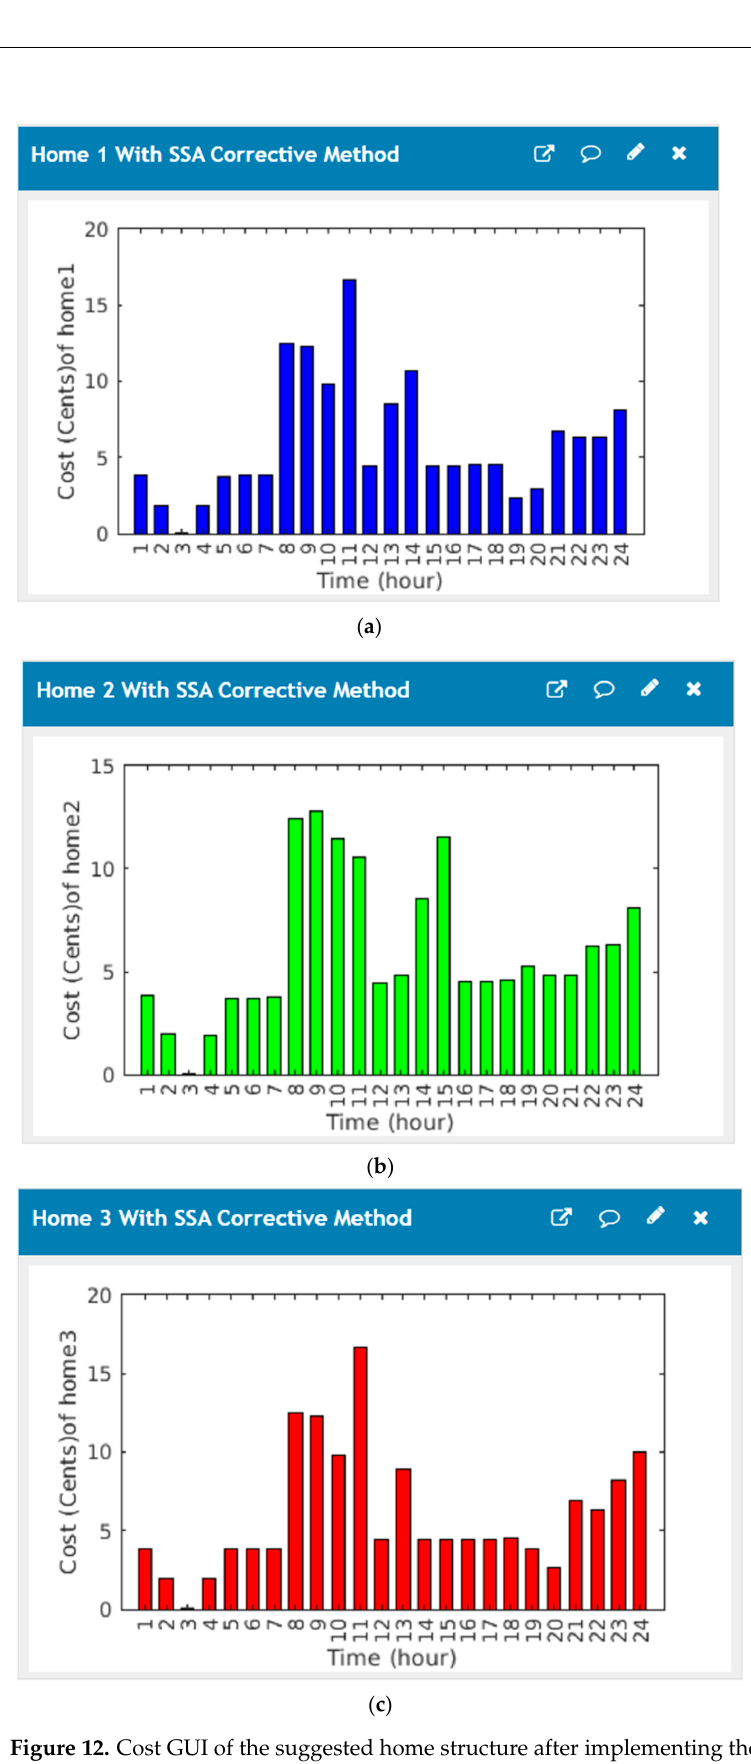
Figure 12. Cost GUI of the suggested home structure after implementing the SSA algorithm: ( a ) cost profiles of first house; ( b ) cost profiles of second house; ( c ) cost profiles of third house.